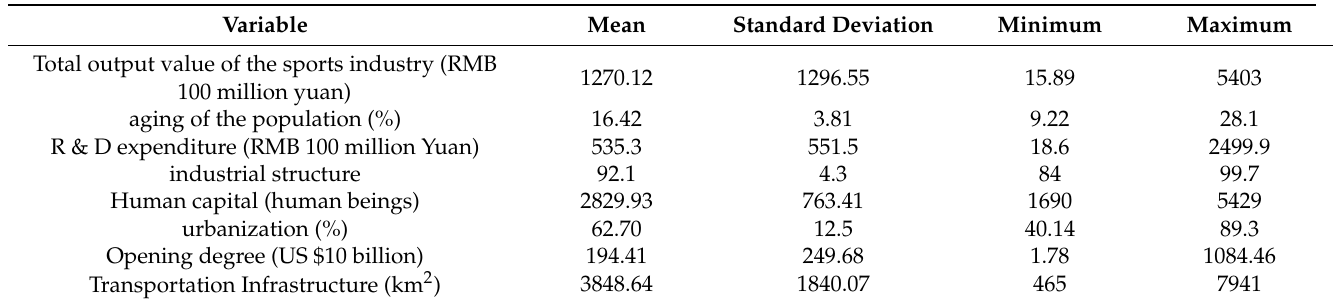
Table 1. Descriptive